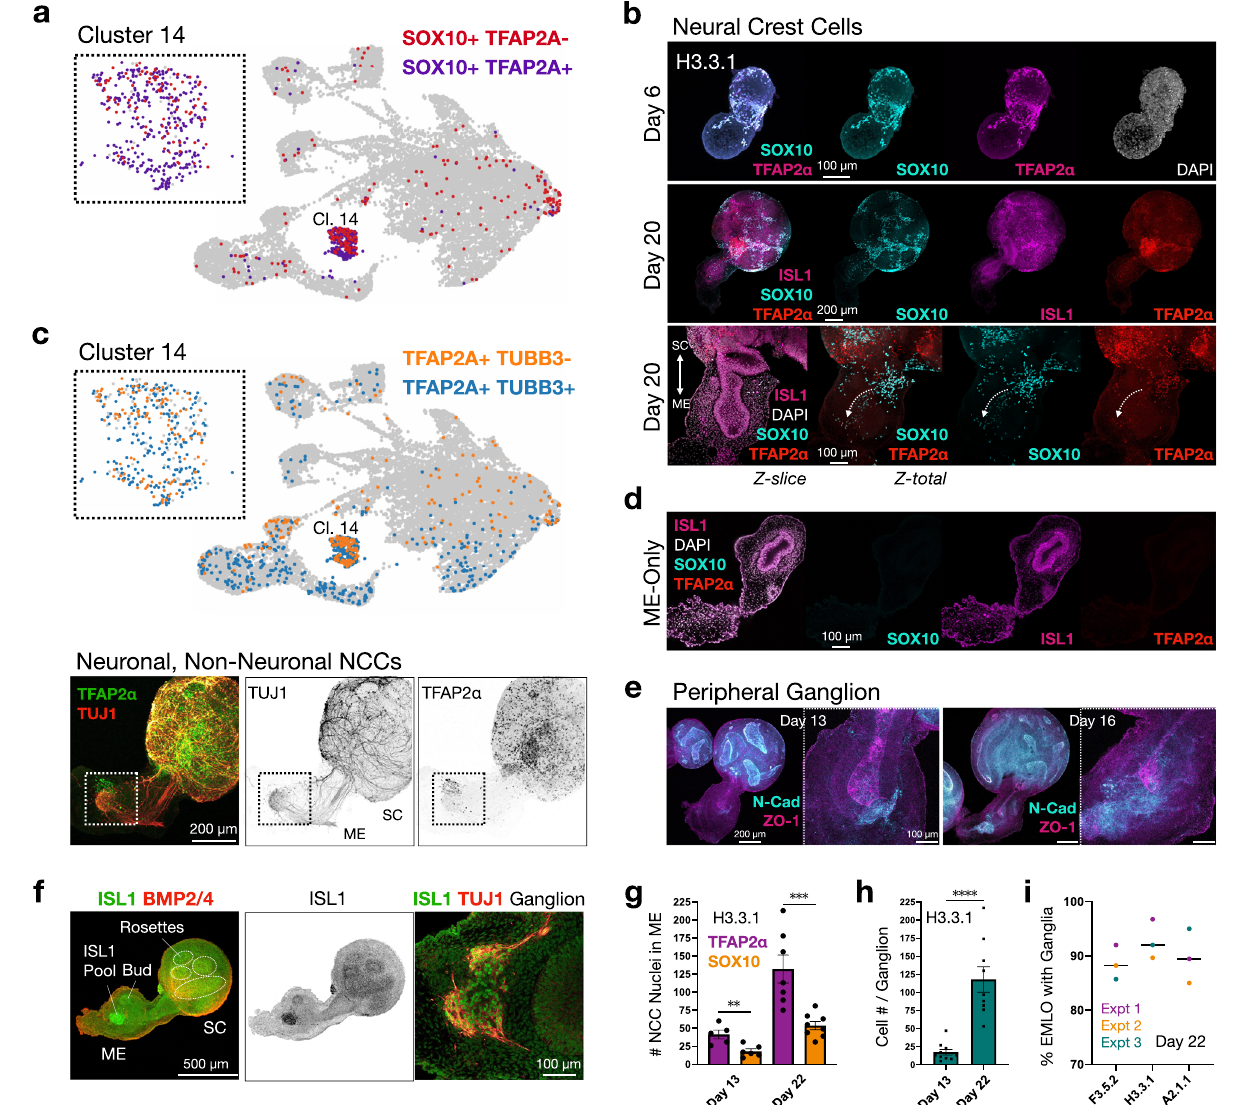
Fig. 7 Diverging NCC lineages populate the ME. a Two SOX10- expressing neural crest cell (NCC) populations are distinguished by TFAP2A expression (purple) and non-expression (red) in day 16 EMLOs by scRNAseq. NCC cluster 14 is expanded. b TFAP2 α (magenta) and SOX10 (cyan) double-positive cells in day 6 H3.3.1 EMLO (top) and diverging NCC lineages by distinct SOX10/TFAP2 α immunostaining in day 20 EMLO (middle). High magni fi cation representative day 20 EMLO is shown (bottom). White dotted arrows depict potential NCC migration about the gut tube. c Two TFAP2A- expressing NCC populations are distinguished by TUBB3 expression (blue) and non-expression (orange) (top). The NCC cluster 14 is expanded. The subsets of putative neuronal (TFAP2 α + in green, TUJ1 + in red) and non-neuronal (TFAP2 α + , TUJ1 − ) NCCs are visualized as well by IF that is best seen at the ganglion in the white dotted box (bottom). TFAP2 α signal is higher outside of the ganglion. d EMLOs lacking the spinal cord (SC) compartment does not contain NCCs, supporting an origin in SC. e N-cadherin (cyan) expression restricted to SC and the gut tube anterior pole, counterstained with ZO-1 (magenta) and shown at days 13 and 16. High magni fi cation images provided. f ISL1 (green) and BMP2/4 (ref) IF in day 22 H3.3.1 EMLOs. ISL1 + cellular pools in proximity to the gut tube are observed in both lines, and increased expression in budding regions of the tube versus non-budding regions. High magni fi cation ISL1 colocalization with TUJ1 is shown (right). NCC biomarkers were stained in H3.3.1 EMLOs in N = 8 of 11 formation experiments, and N = 3 formation experiments for the other representative lines. g Histogram of TFAP2 α (purple) and SOX10 (yellow) positive nuclei in mesoderm – endoderm (ME) over time at day 13 ( n = 5 EMLOs TFAP2 α , n = 6 EMLOs SOX10) versus day 22 ( n = 7 EMLOs TFAP2 α , n = 8 EMLOs SOX10) in H3.3.1 EMLOs. (unpaired two- tailed t test ** p = 0.0033, t = 3.814, df = 10 TFAP2 α ; *** p = 0.0004, t = 4.873, df = 12). h Plot of cell number (DAPI/TUJ1) per ganglion over time at day 13 ( n = 10 EMLOs) versus day 22 ( n = 9 EMLOs) in H3.3.1 EMLOs (**** p < 0.0001, t = 5.854, df = 17). Data reported as (mean ±s.e.m.). i Histogram quanti fi cation of EMLOs with neuronal ganglionic structures in ME in F3.5.2 ( n = 25), H3.3.1 ( n = 31), and A2.1.1 ( n = 19) ED-hiPSC lines at day 22 (median). Colors denote N = 3 separate formation experiments. Individual scale bars